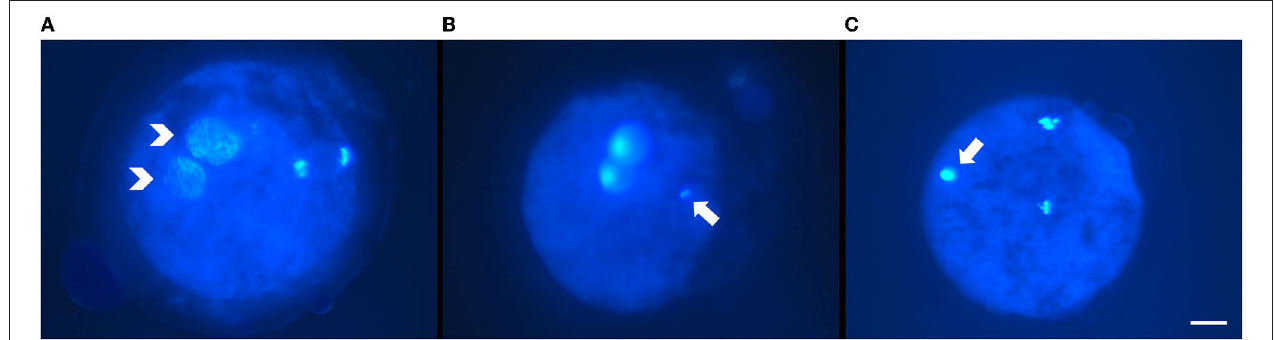
FIGURE 1 | Representative micrographs of fertilization pattern obtained after intracytoplasmic sperm injection (ICSI) of ultra-rapid frozen or control slow-frozen feline spermatozoa and Hoechst staining. (A) Pattern of normal fertilization: two pronuclei (white arrowheads). (B,C) Other fertilization patterns: (B) metaphase II arrest with intact sperm head (white arrow); metaphase II was placed out of focus to allow better visualization of the sperm head. (C) metaphase II arrest with decondensing sperm head (white arrow). Scale bar: 20 µ m, objective 40X.